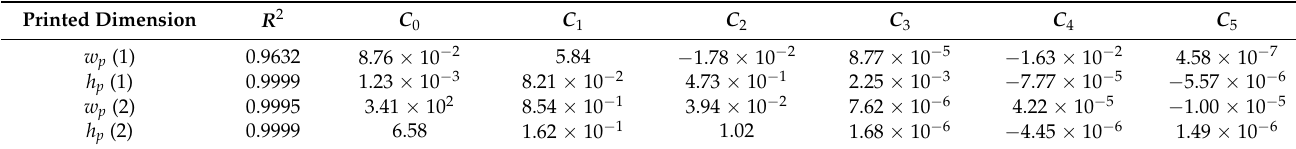
Table 1. Parameters of the mathematical model to predict printed